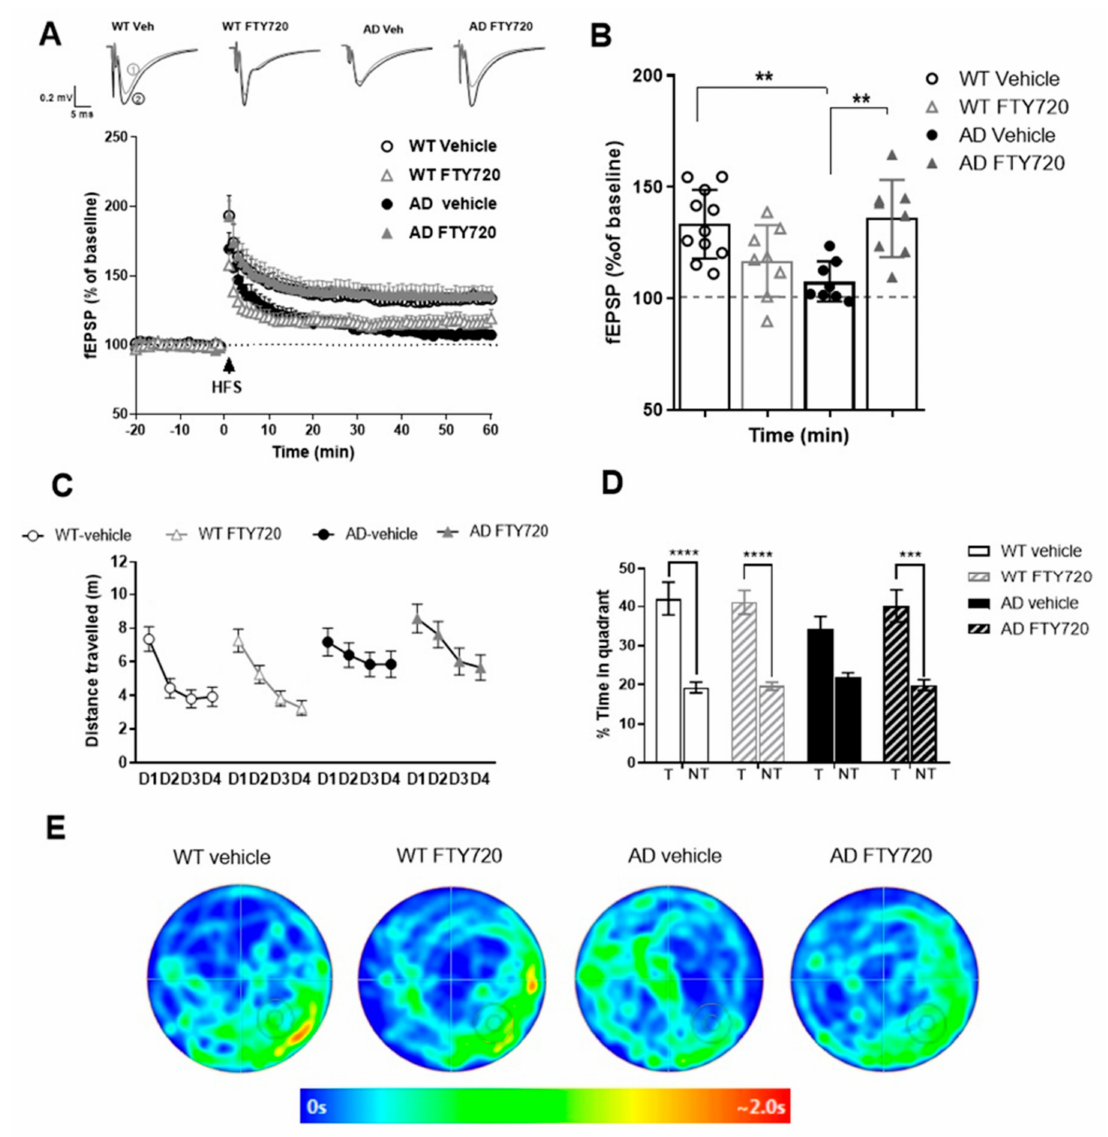
Figure 3. Chronic treatment with fingolimod (FTY720) rescues LTP and ameliorates spatial memory in APP / PS1 mice. ( A , B ) Long-term potentiation evoked by high-frequency stimulation (HFS) in six- to seven-month-old WT and APP / PS1 mice after chronic vehicle or FTY720 treatment. ( A ) The graphs show the time-course of slope (normalized to baseline) of field excitatory postsynaptic potentials (fEPSPs) before and after induction of LTP with high frequency stimulation (HFS). Representative traces for each condition are shown before (1—grey) and 60 min after LTP induction (2—black). ( B ) Average of fEPSP slopes between 45–60 min after HFS. WT Vehicle ( n = 11 slices from three animals), AD Vehicle ( n = 8 / 3), WT FTY720 ( n = 8 / 3) and AD FTY720 ( n = 8 / 3). ( C – E ) Spatial learning and memory retrieval after chronic vehicle or FTY720 treatment. ( C ) Spatial learning training in a Morris water maze from training day 1 (D1) to training day 4 (D4) represented as distance travelled to the platform. ( D ) Memory recall (probe trial), 24 h after the last training day (D4), represented as percent time spent in target (T) and average of nontarget quadrants when the platform was removed. WT vehicle ( n = 18), AD vehicle ( n = 15), WT FTY720 ( n = 20) and AD FTY720 ( n = 16). Horizontal bars indicate statistical significance between selected groups. ( E ) Heat maps represent the average occupancy time of di ff erent locations in the maze (red: high; blue: low residence time) for a set of animals from each group. Target quadrant (bottom right) is marked with the platform zone circle. Significance of di ff erences was tested with two-way ANOVA. Di ff erent levels of significance are indicated by asterisks: ** p < 0.01, *** p < 0.001; **** p <